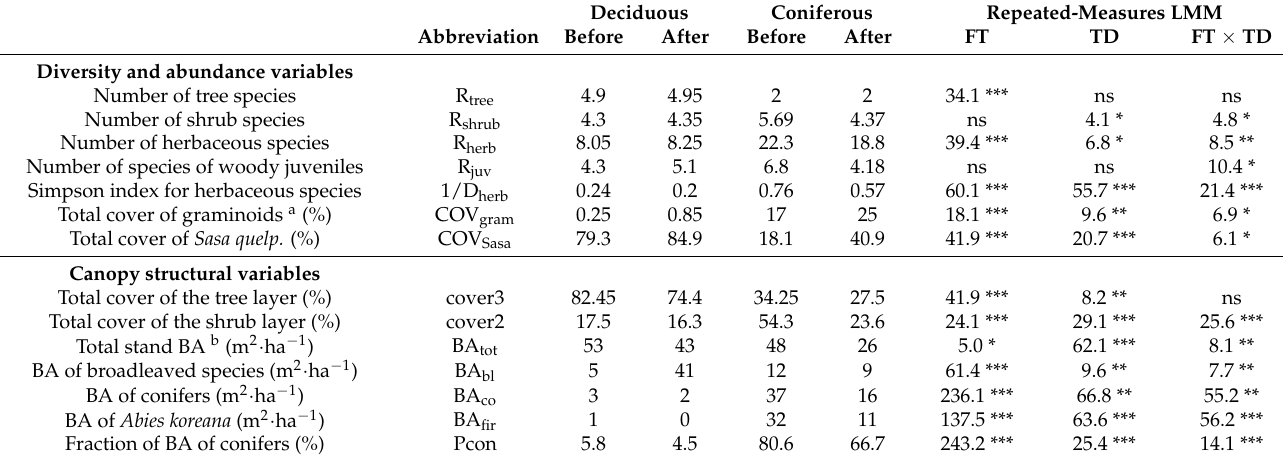
Table 2. Description of the studied diversity, structural and soil variables, their abbreviations used in analyses, the mean values for both deciduous and coniferous forests before and after typhoon disturbance, and the F-test and p -values from repeated-measures linear mixed models (LMMs) testing the effect of forest type (FT), typhoon disturbance (TD), and their interaction (TD × FT). ns: no significant difference; * p < 0.05; ** p < 0.01; *** p <